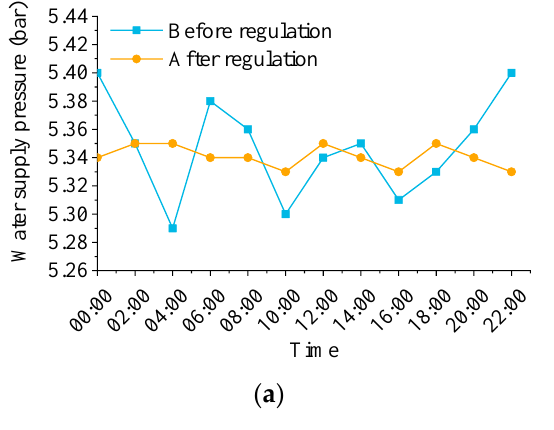
Figure 16. ( a ) Pressure fluctuation of secondary water supply before and after regulation. ( b ) Fluctuation in differential pressure between secondary supply and return before and after regulation.